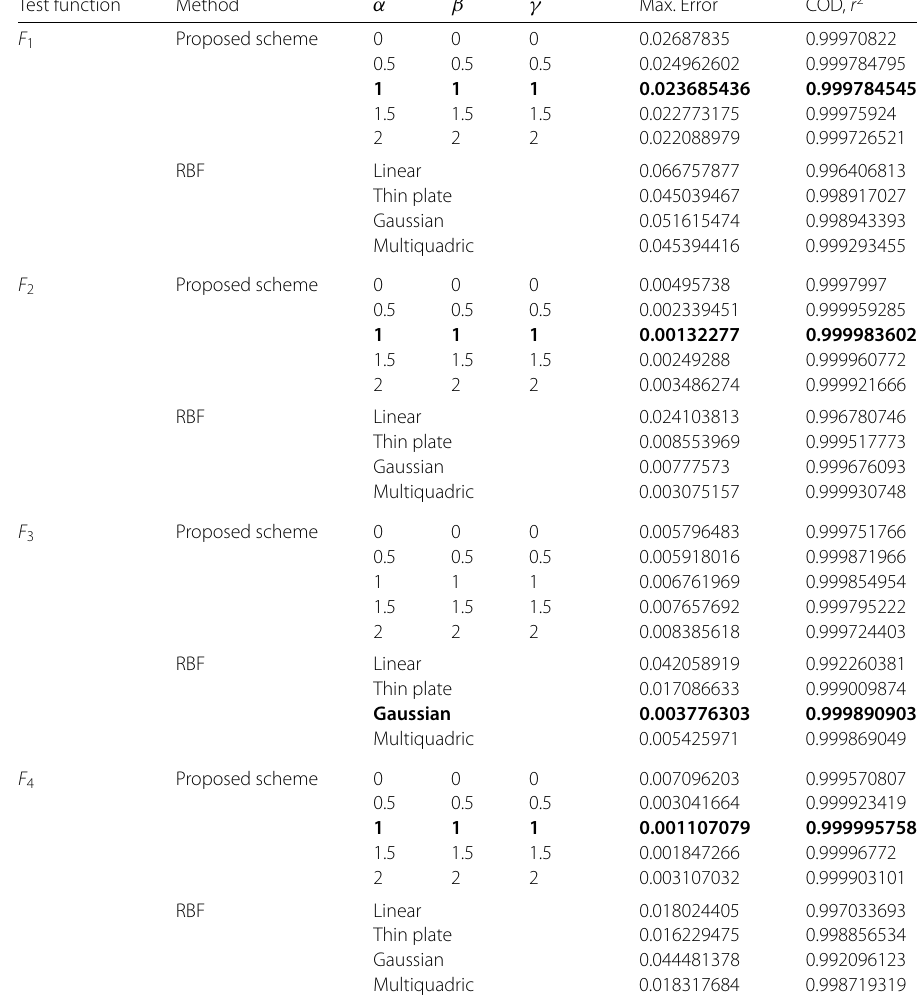
Table 2 Error measurement for 65 data